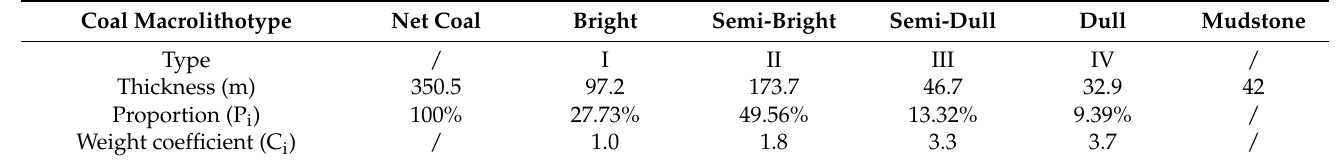
Table 5. Weight coefficient assignments for different coal